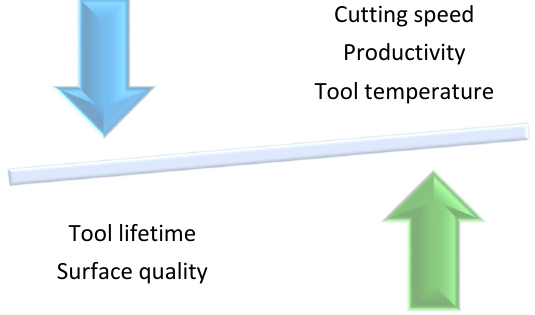
Figure 1. Inverse proportionality of machining parameters.